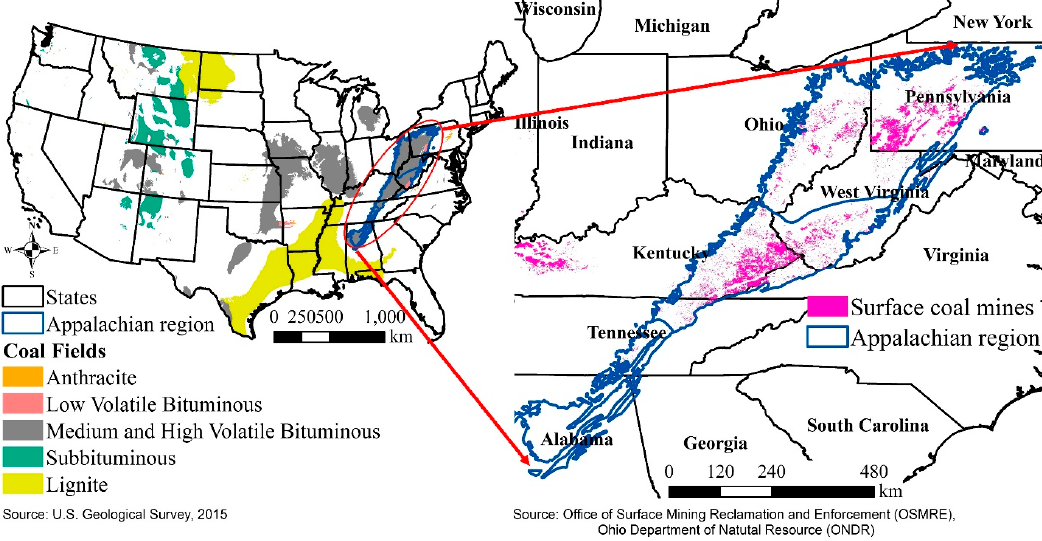
Figure 1. Geographical distribution of coal mined lands across the USA and the Appalachian region.